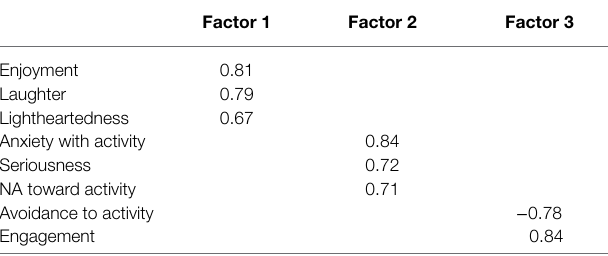
TABLE 2 | The construct of coding items based on EFA.